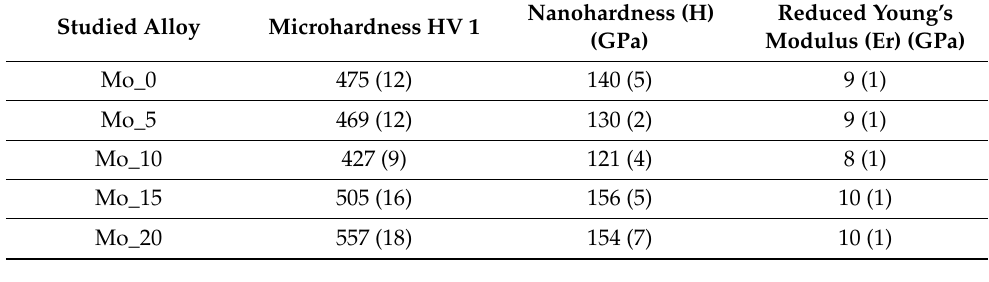
Table 6. Average microhardness (HV 1), nanohardness (H) and reduced Young’s modulus (Er) for different Mo content for all studied high entropy alloys.